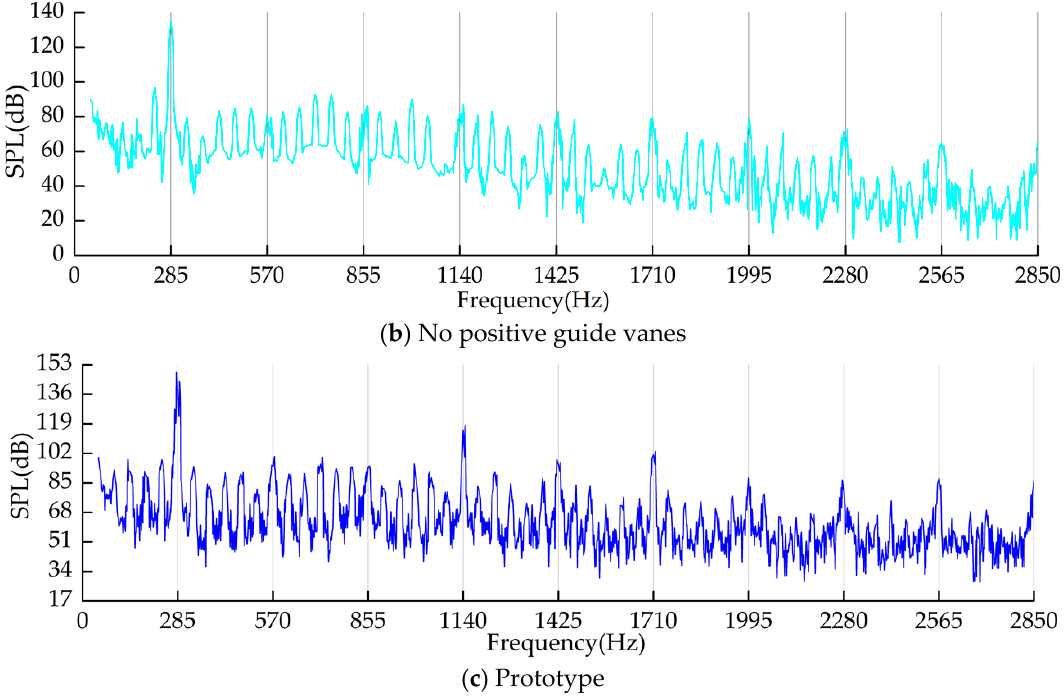
Figure 8. Frequency response curves of the hydroacoustic sound pressure level (SPL) of the impeller with different blade numbers of the guide